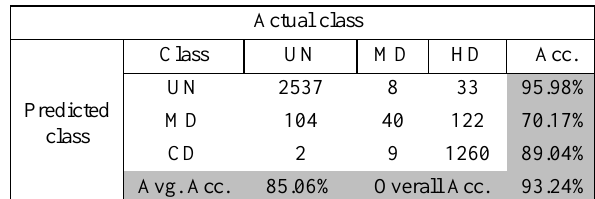
Table 5. Confusion matrix of Fuzzy Logic System Classification